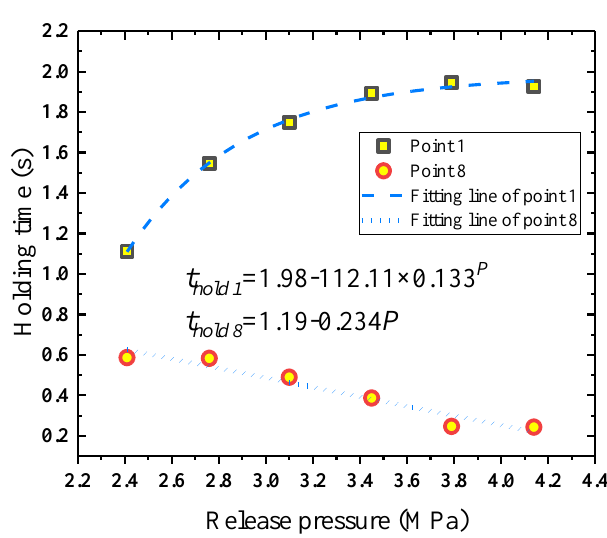
Figure 17. The holding time at points 1 and 8 at different release pressures.